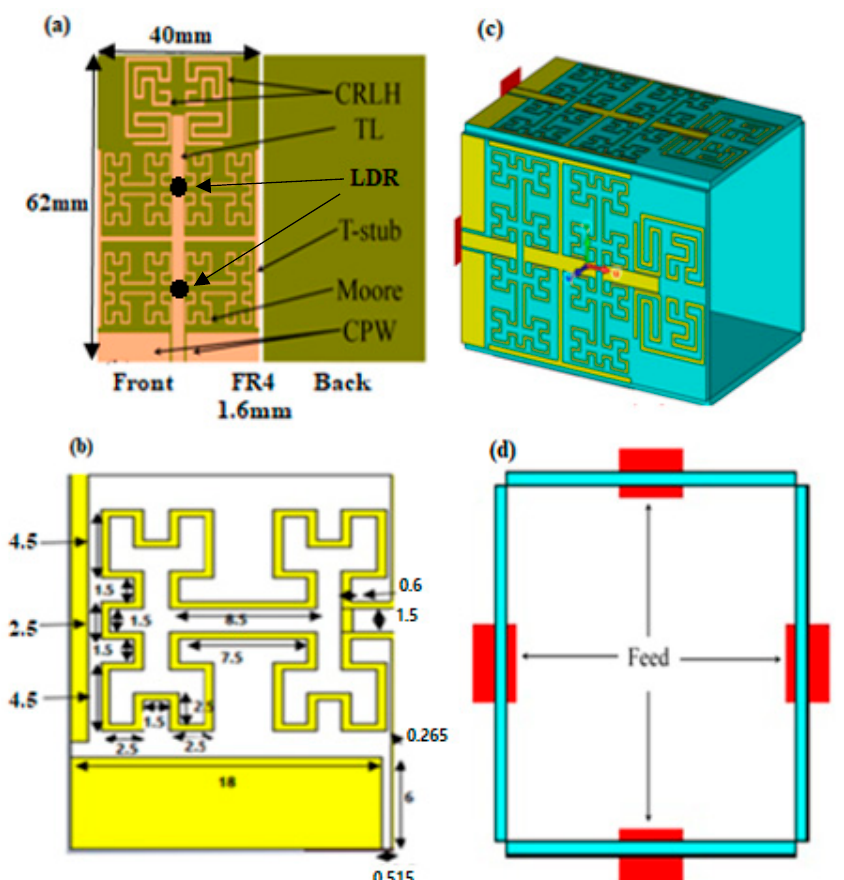
Figure 1. Antenna geometrical details: ( a ) Single-antenna elements, ( b ) one Moore fractal, ( c ) MIMO array 3D view, and ( d ) MIMO array top view. All dimensions are in mm scale.